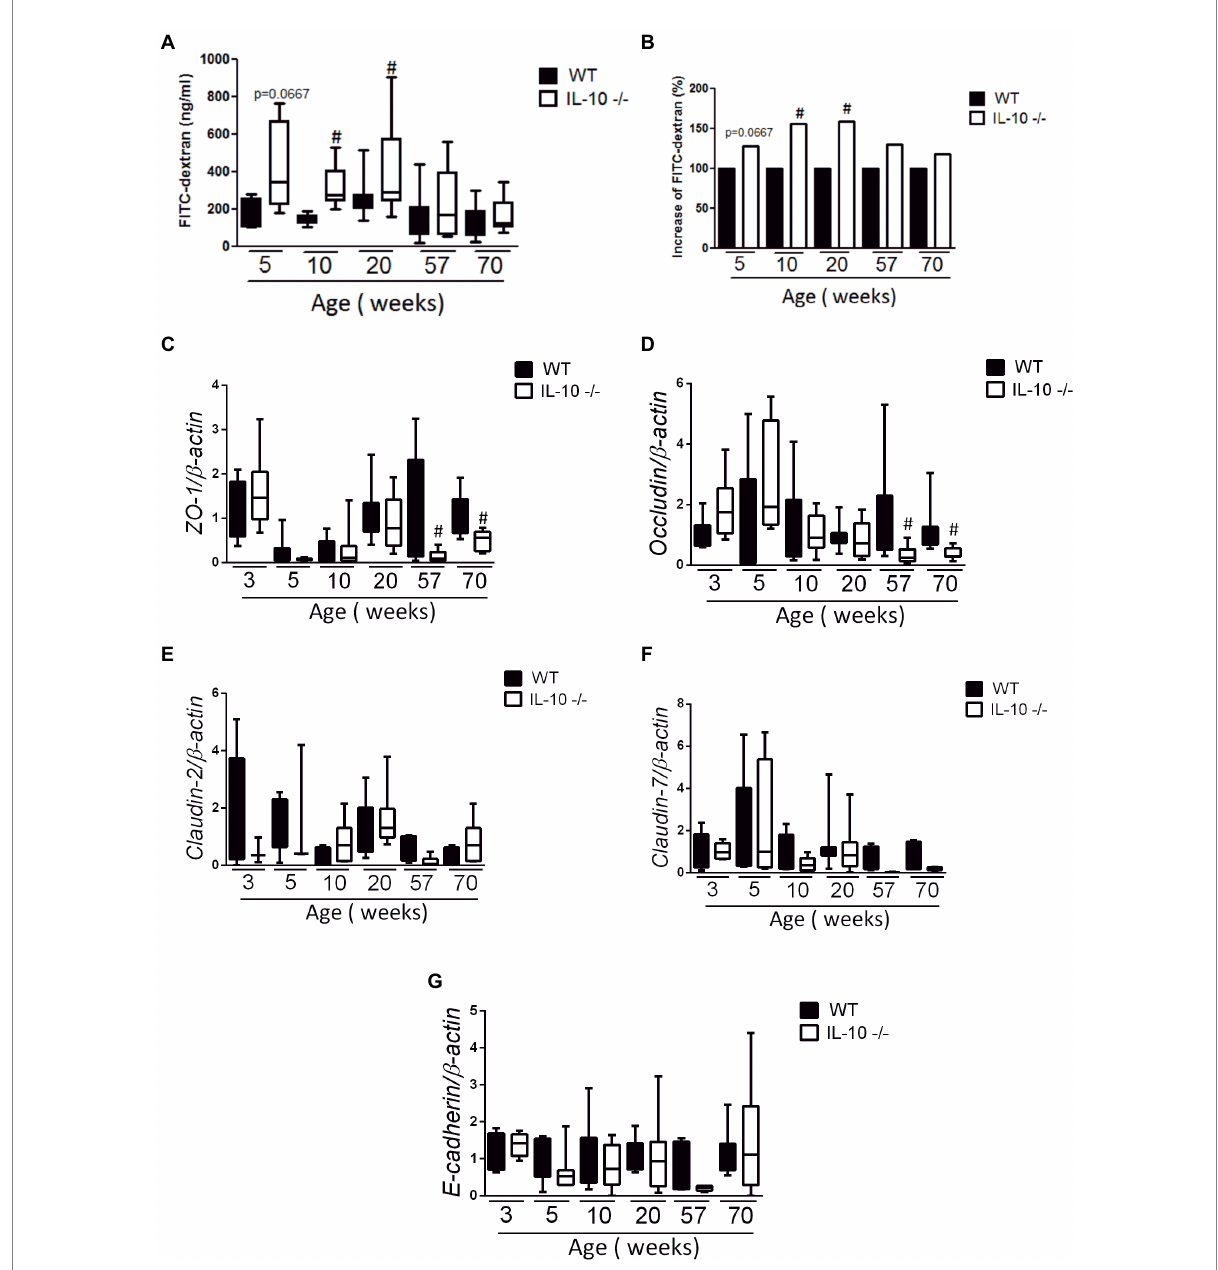
FIGURE 3 In vivo permeability and gene expression of adhesion molecules. Measurement of fluorescein isothiocyanate (FITC-dextran) fluorescence in serum after passive diffusion through the intestinal epithelium and after rectal administration ( n = 6 for each strain and age); absolute values (A) and percentage increase (B) . Comparison of gene expression of adhesion molecules ZO-1 (C) , Occludin (D) , Claudin-2 (E) , Claudin-7 (F) and E-cadherin (G) . The normalization was carried out based on the housekeeping gene β -actin and three independent replications were made